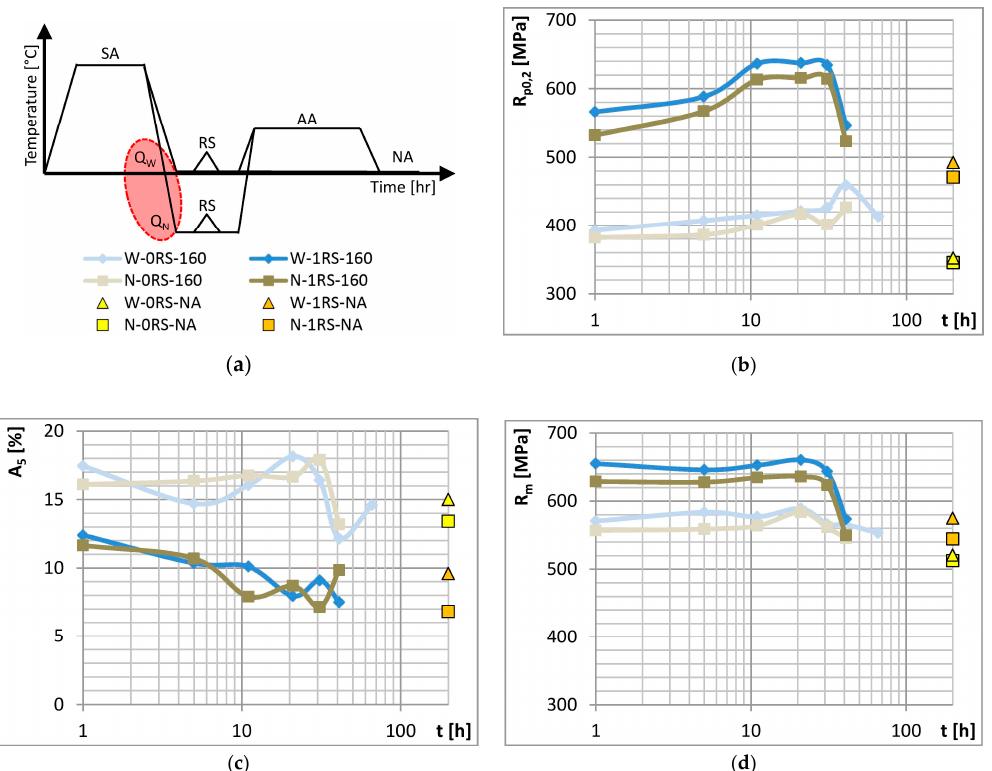
Figure 2. ( a ) Schematic representation of the cooling rate experiment and its results: ( b ) yield strength ( c ) elongation and ( d ) ultimate strength vs. time of AA (the time of NA was 1 month but the operation is indicated at t = 200 h).